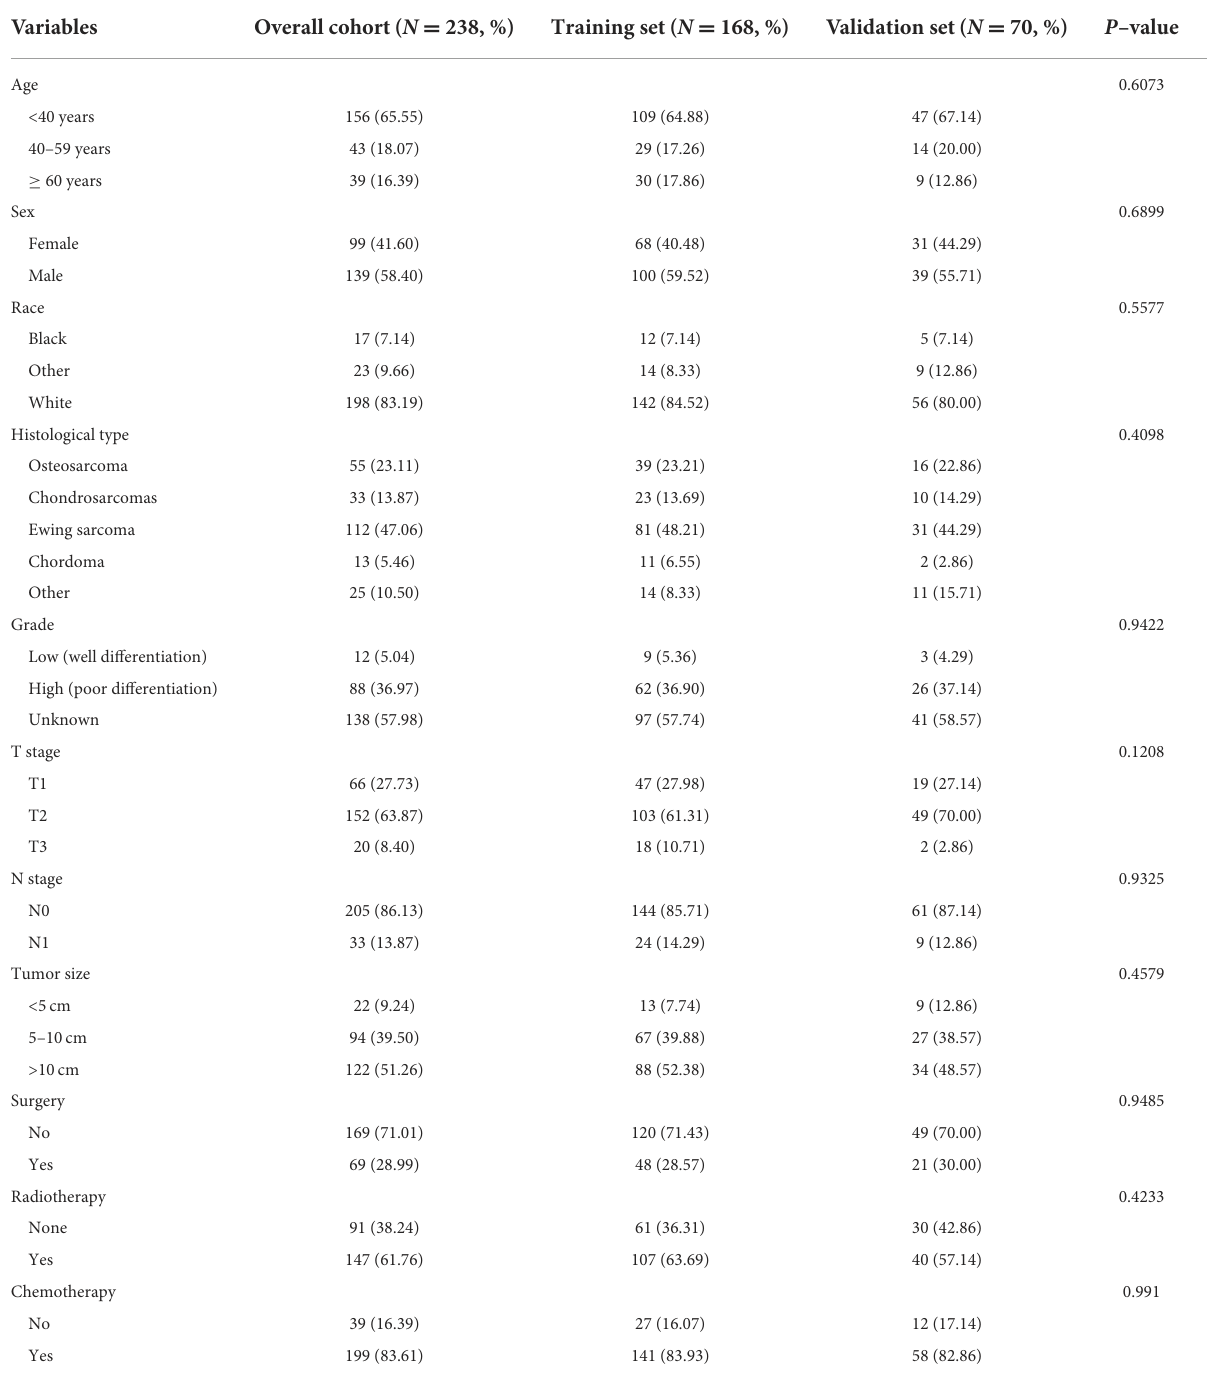
TABLE 3 The baseline data of POSNs patients with